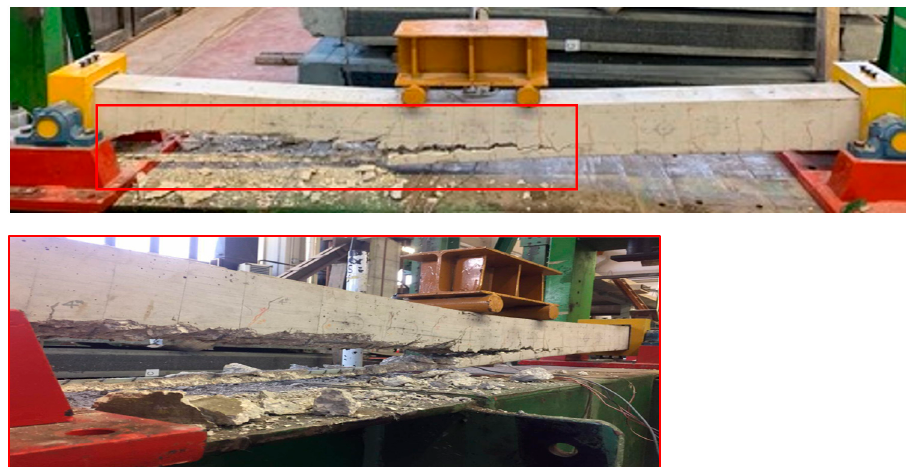
Figure 4. Failure mode of specimen B1 GFRP .